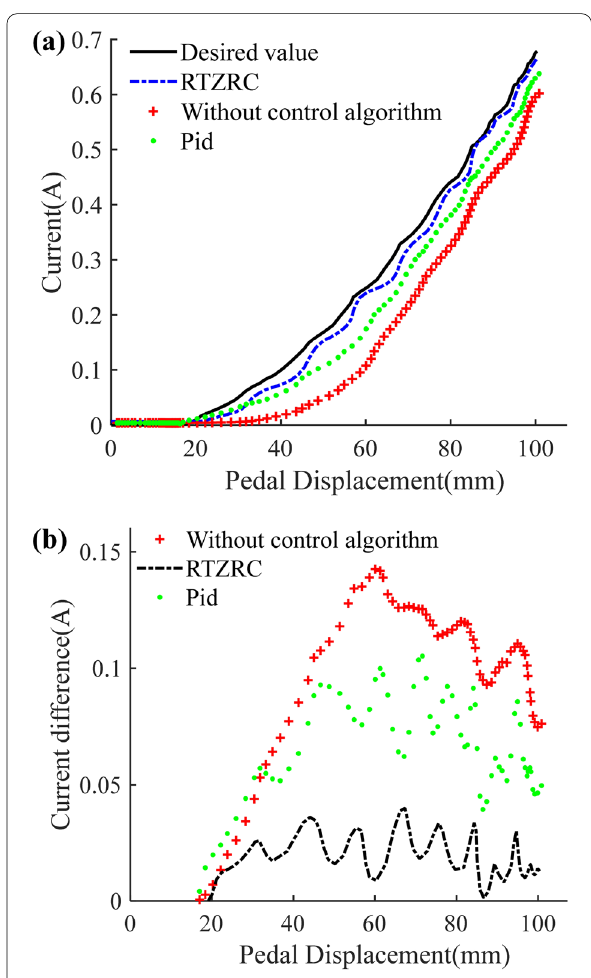
Figure 13 Effect of the proposed control algorithm on ( a ) current and ( b ) current difference